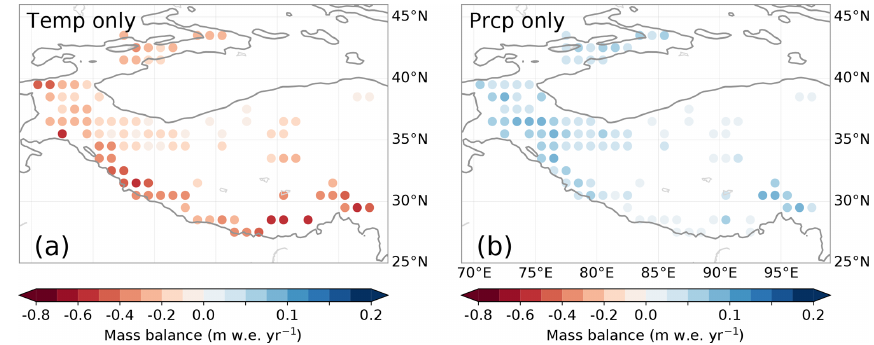
Figure 13. Simulated mean mass balance between 2000 and 2010 forced by a spatially uniform and constant temperature increase of + 0 . 01 ◦ Cyr − 1 , with snowfall kept constant (a) , and a spatially uniform and constant snowfall increase of + 0 . 5%yr − 1 of the annual mean value, with temperature kept constant (b) . Panels (a) and (b) thus show the relative sensitivity to temperature and snowfall, respectively.